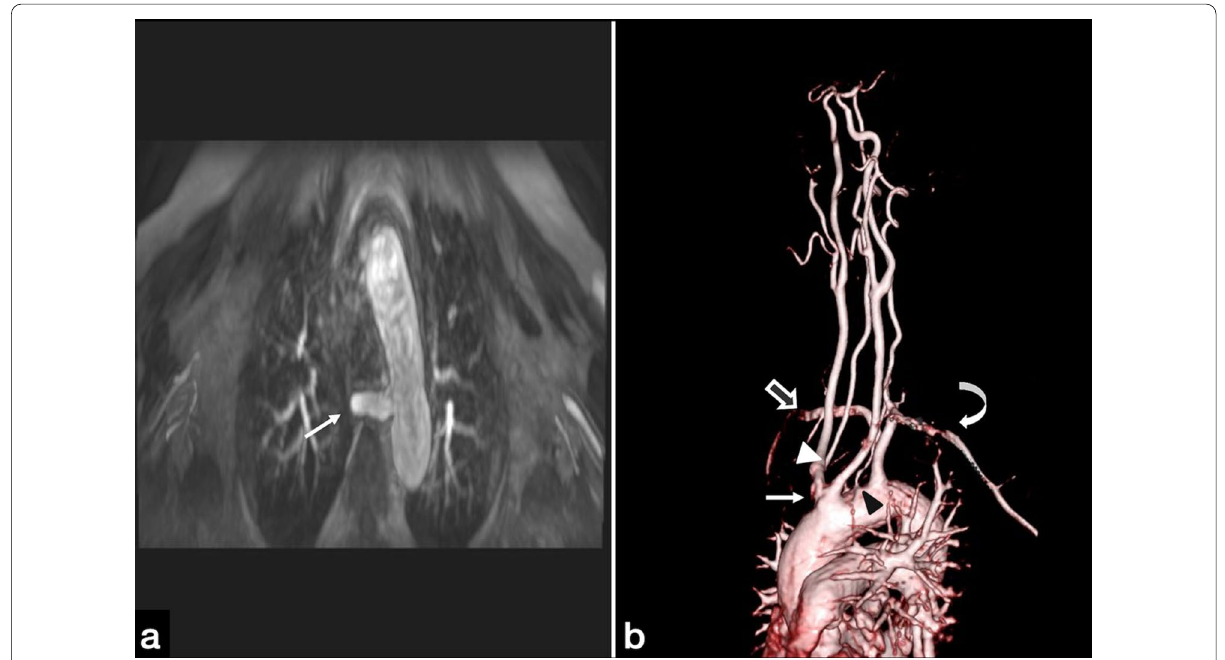
Fig. 2 a Magnetic resonance angiography image shows the aberrant right subclavian artery originating as the last branch of the aortic arch (arrow). b Bicarotid trunk (arrow), ARSA (blank arrow), RCCA originated RVA (white arrowhead), aortic arch origin LVA (black arrowhead) and LSCA (curved arrow) are seen in 3D reconstruction